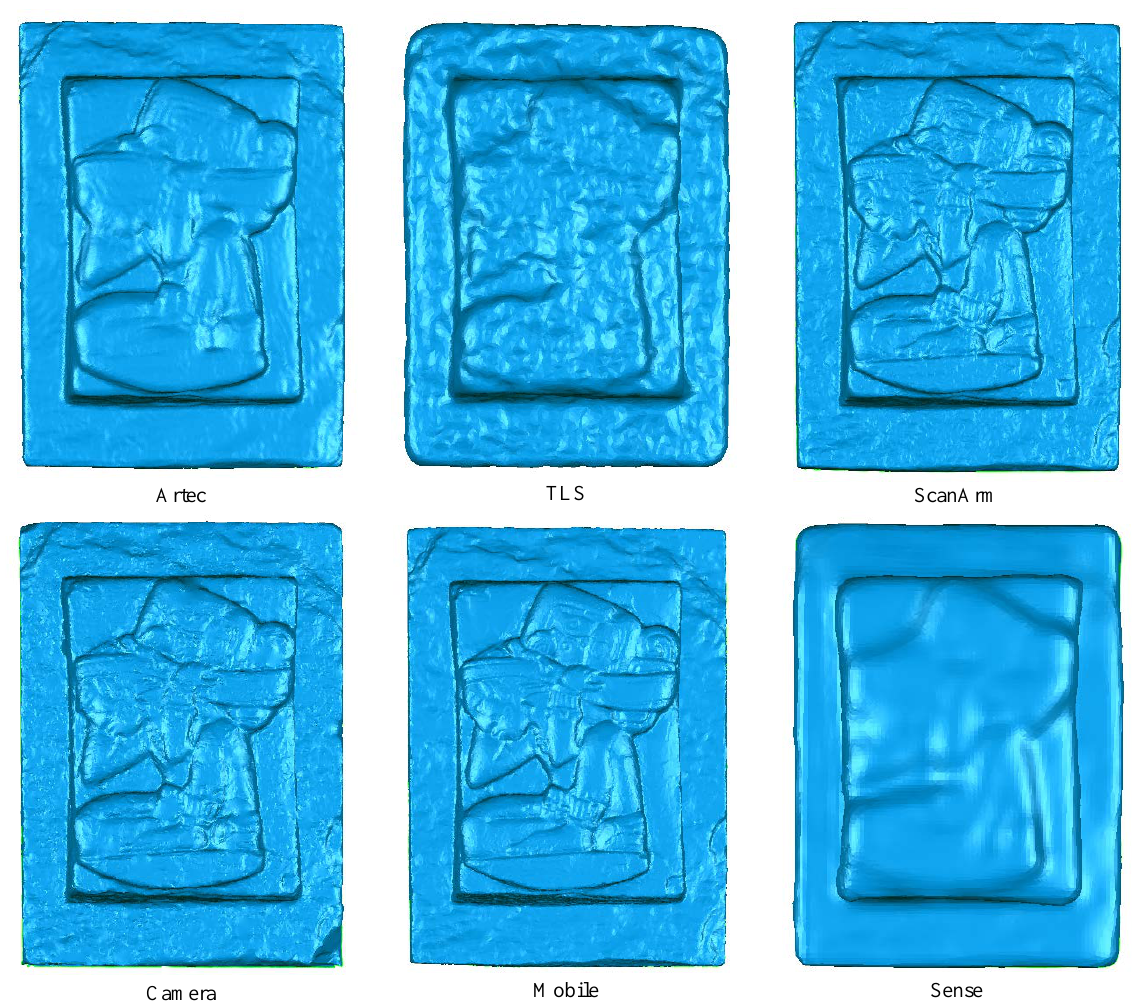
Figure 3. Triangulated surface